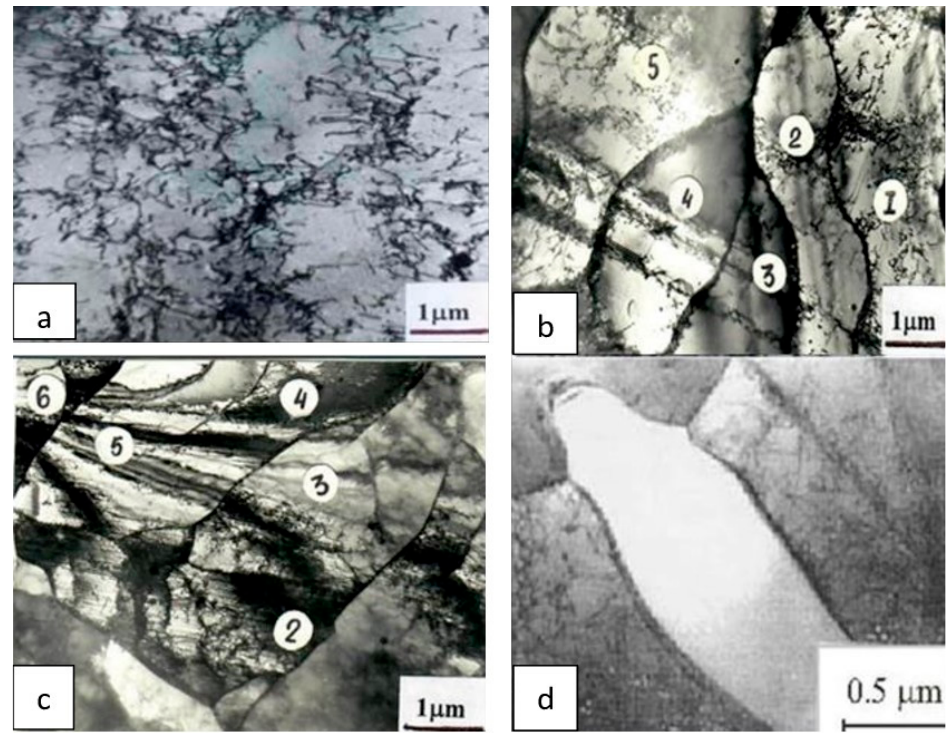
Figure 1. Transmission electron micrographs of weakly misoriented cellular ( a ), fragmented ( b , c ), and recrystallized ( d ) structures in Cr-Ni-Ti austenitic stainless steel after fractional deformation ( c ) and after single-stage deformation ( a , b , d ): ( a ) Number of passes n = 1, ε = 10%; ( b ) n = 1, ε = 10%; ( c ) n = 5, ε = 10%; ( d ) n = 1, ε = 30%; 1–6 fragments on which the crystallographic orientation ( θ ) has been determined. Table 2. Misorientation in Cr-Ni-Ti austenitic stainless steel after TMCP, according to modes with different numbers of passes (n) and strain degrees ( ε ).